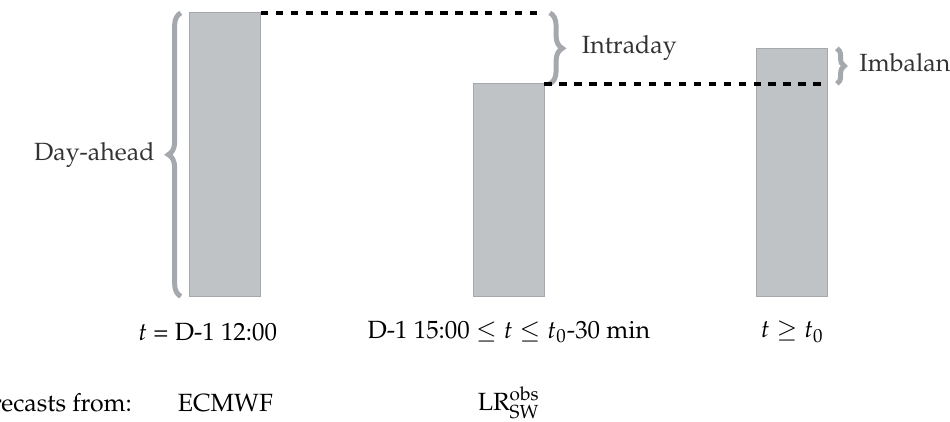
Figure 2. Electricity market organization for delivery at time t 0 . The day-ahead market operates as a one-time auction at 12:00 on the day before the delivery date, for each slot of the next day. The intraday market opens at 15:00 on the day before delivery and operates continuously until 5 to 30 min before the delivery time. Upon delivery, RTE compensates any imbalances using the imbalance market and issues appropriate imbalance payments/collects imbalance penalties from market